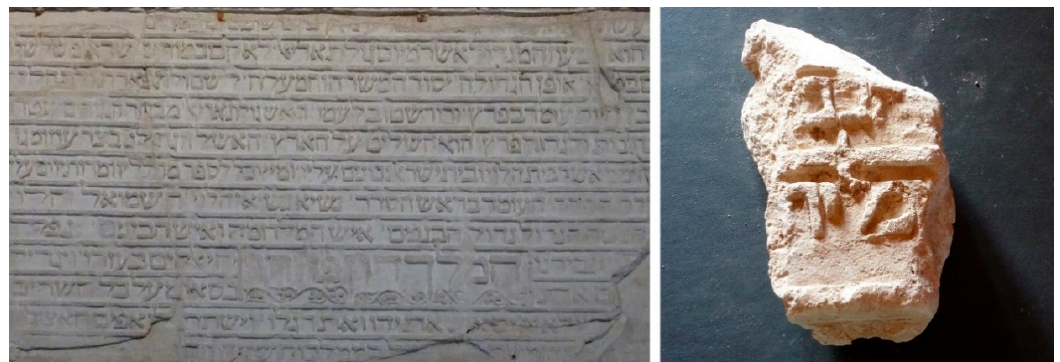
Figure 21. Fragment with epigraphy of Molina de Aragón Synagogue ( right ) compared with the foundation plaque of El Tránsito Synagogue ( left ). Author’s photo.